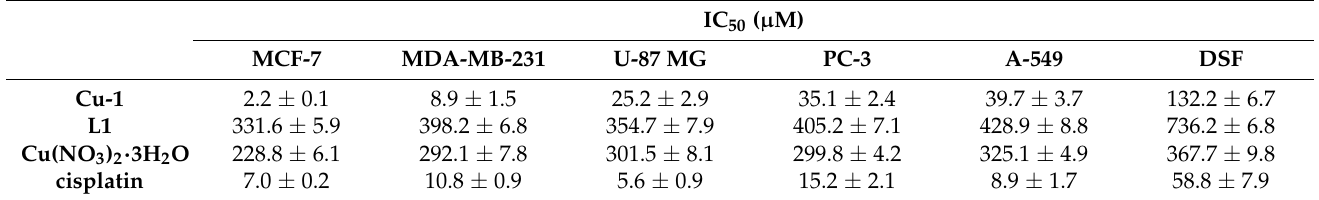
Table 3. Cytotoxicity of complex Cu-1 , L1 , Cu(NO 3 ) 2 · 3H 2 O and cisplatin against a panel of cancer cell lines and one healthy cell line after 72 h treatment